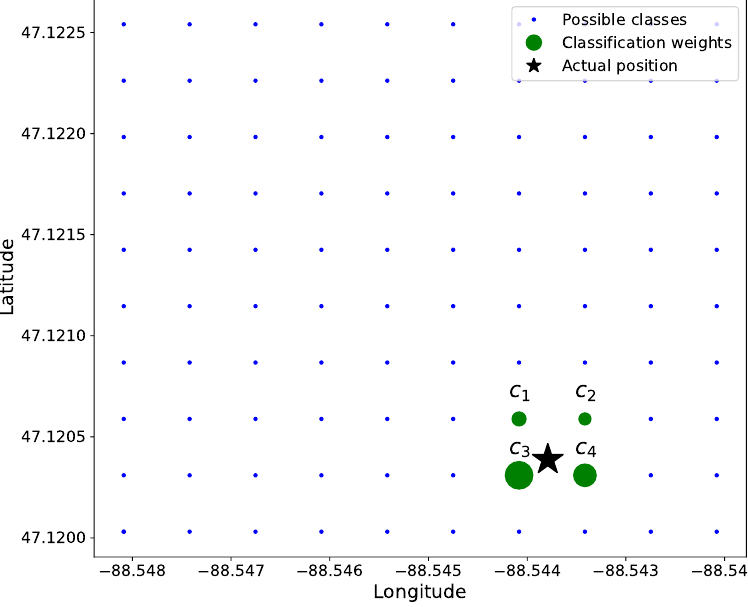
Figure 4. Soft classification of linear position where ∆ = 1. The star is the original position, and the circle size corresponds to the weight of each